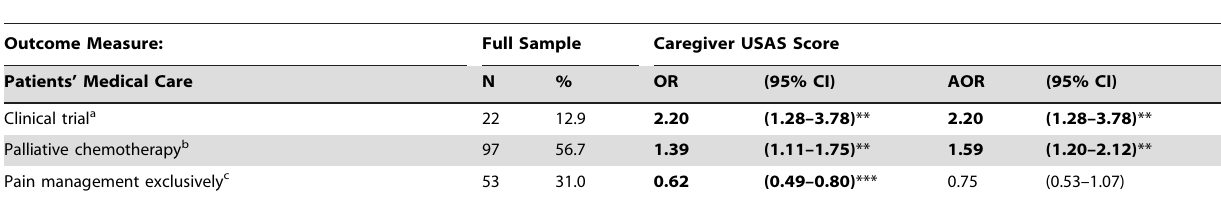
Table 6. Associations between Caregiver Acculturation and Patient Medical Care (N =171).